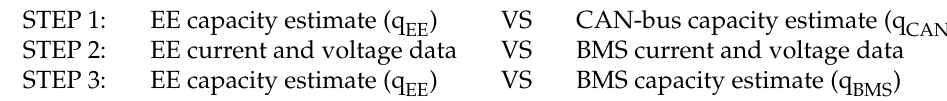
Table 4. Steps for results